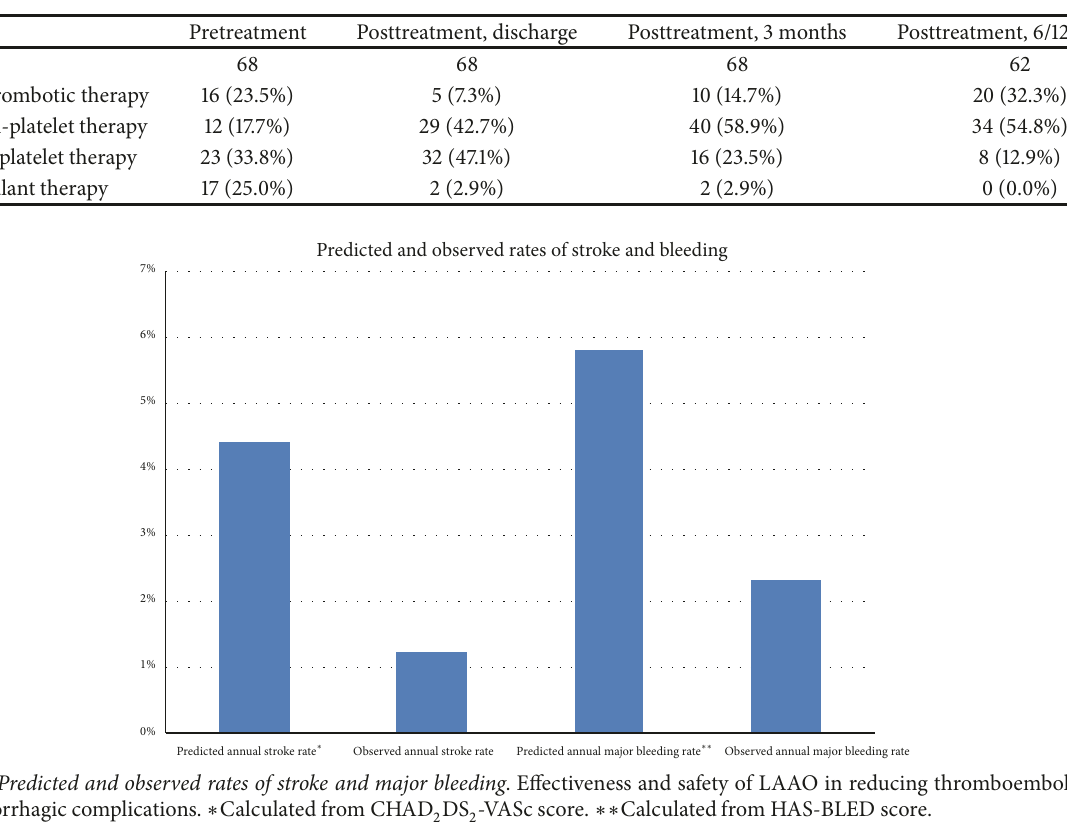
DS -VASc score. ∗∗ Calculated from HAS-BLED 2 2